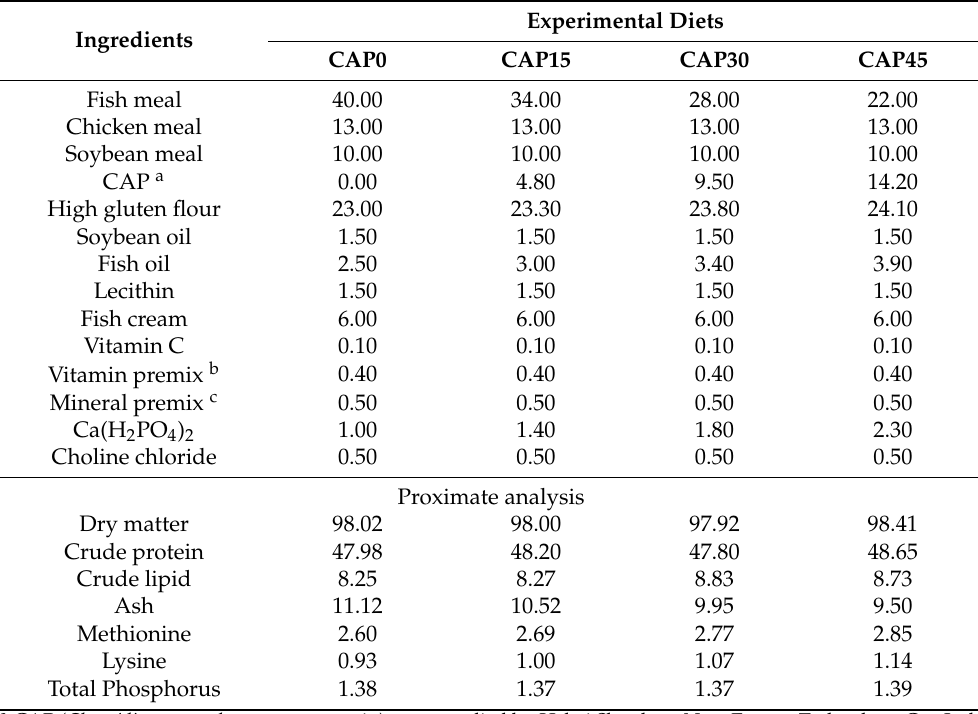
Table 2. Formulation and proximate composition of experimental diets (% dry